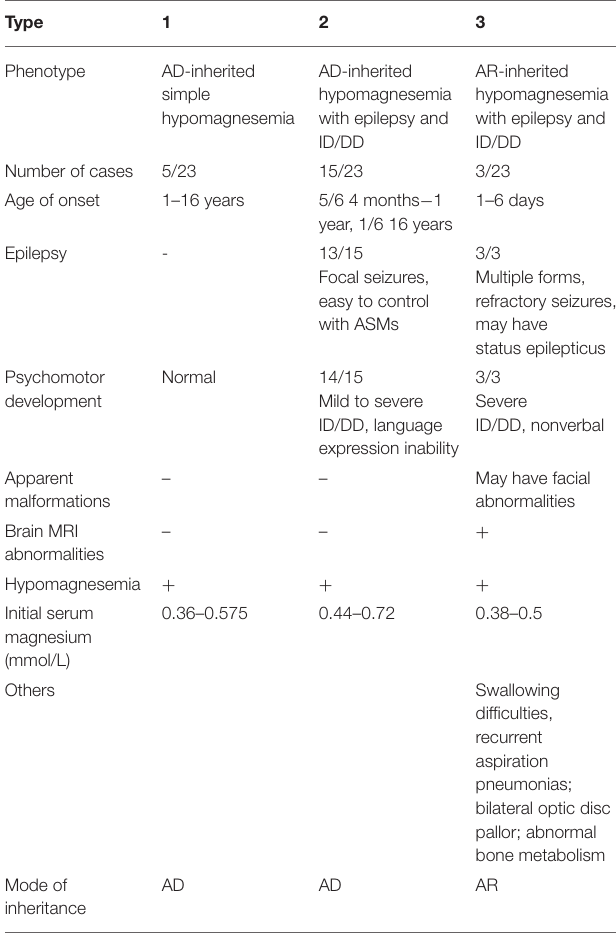
TABLE 3 | Three types of CNNM2 -related disorders and their features.